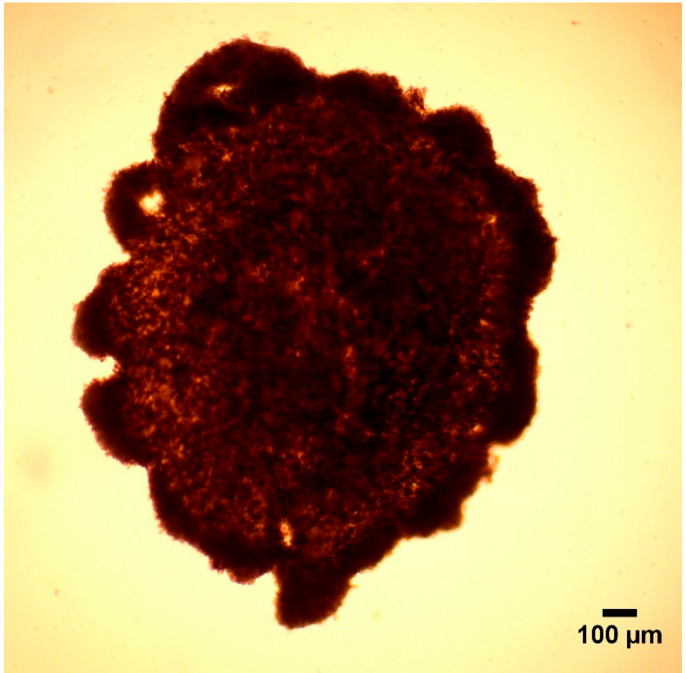
Figure 2. Hepatocyte—non-parenchymal cell co-culture in form of spheroid (40 ×